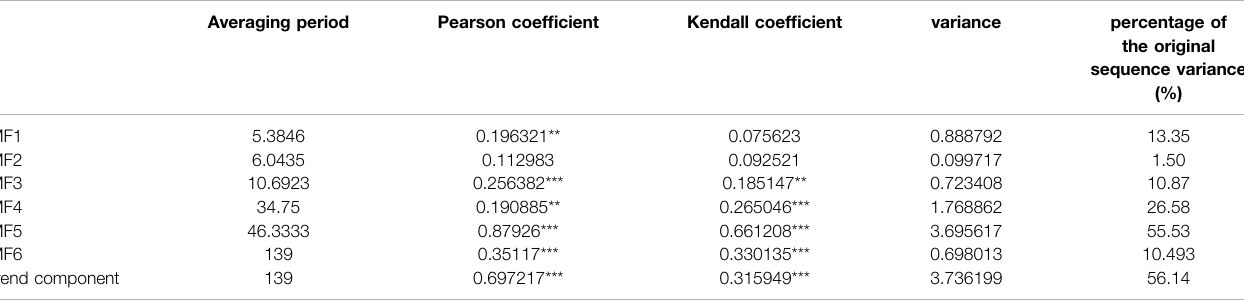
TABLE 2 | Statistics of IMF components and trend component min the time series of hogs ’ monthly